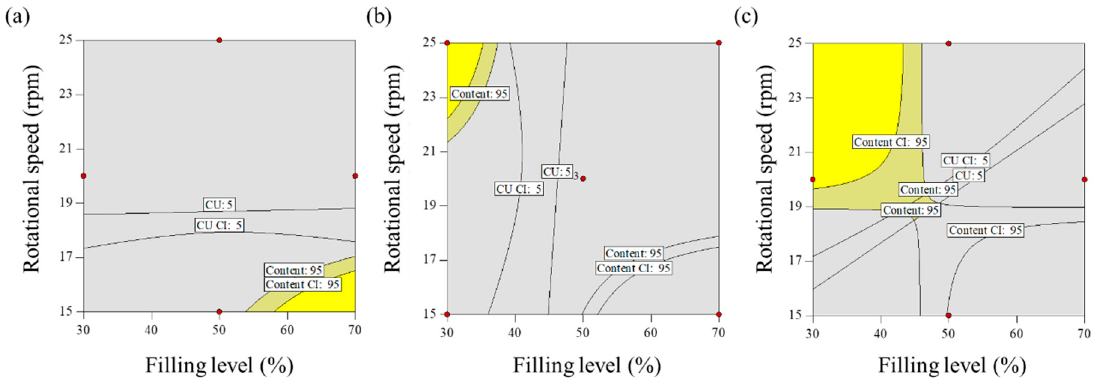
Figure 4. Design spaces to optimize process parameters of blending for amlodipine formulation: blending time at ( a ) 9 min, ( b ) 16.5 min, and ( c ) 24 min. The yellow spaces are parts that satisfy all the target values of IQAs.